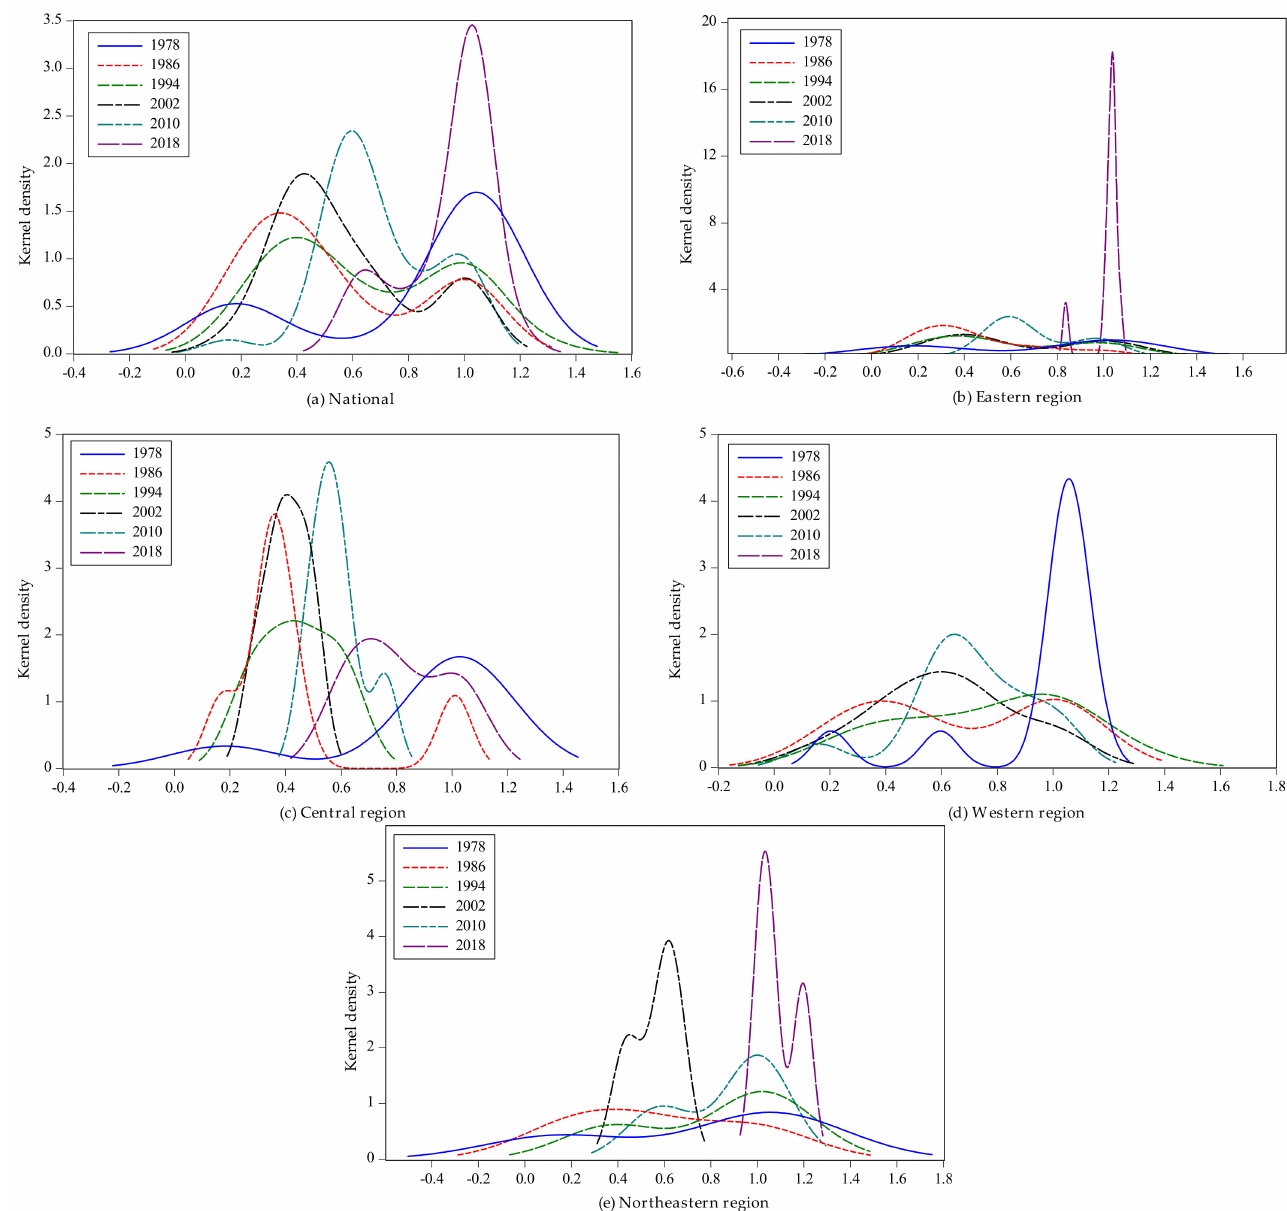
Figure 2. The KDE of APE under climate change during 1978–2018. ( a ) is the kernel density estimation at the national level; ( b ) is the kernel density estimation of the eastern region; ( c ) is the kernel density estimation of the central region; ( d ) is the kernel density estimation of the western region; ( e ) is the kernel density estimation of the northeastern